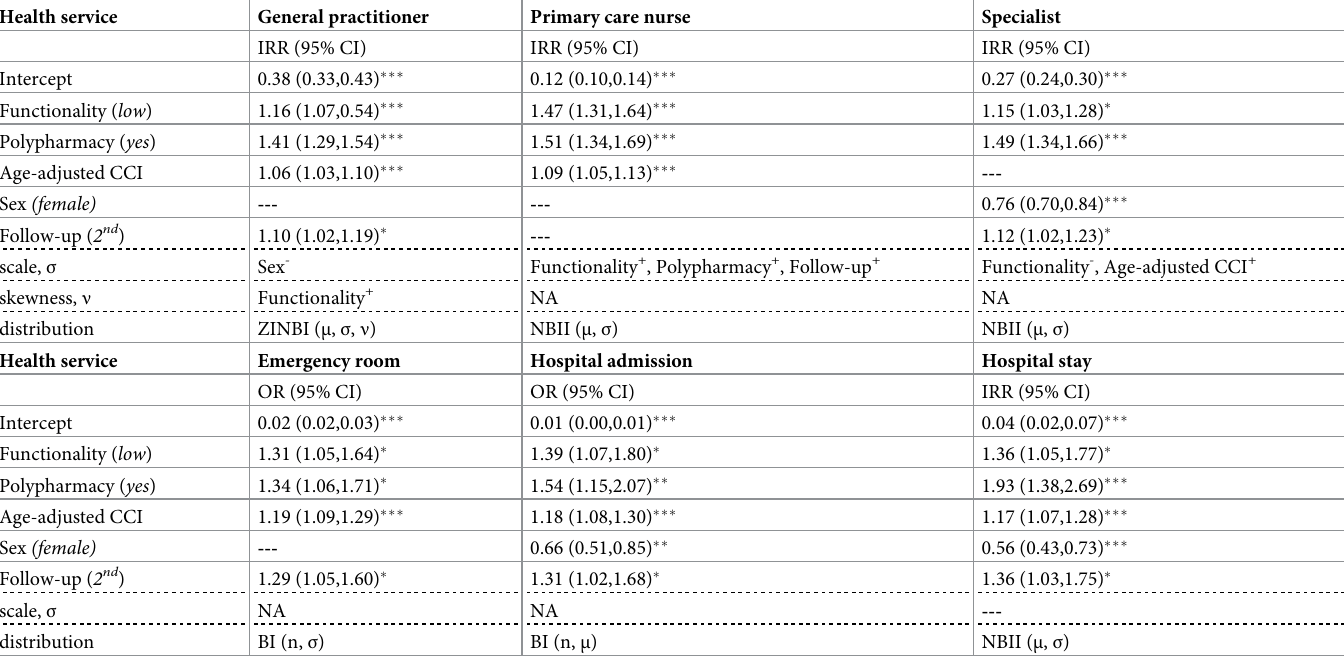
Table 3. GAMLSS models for the use of health services.